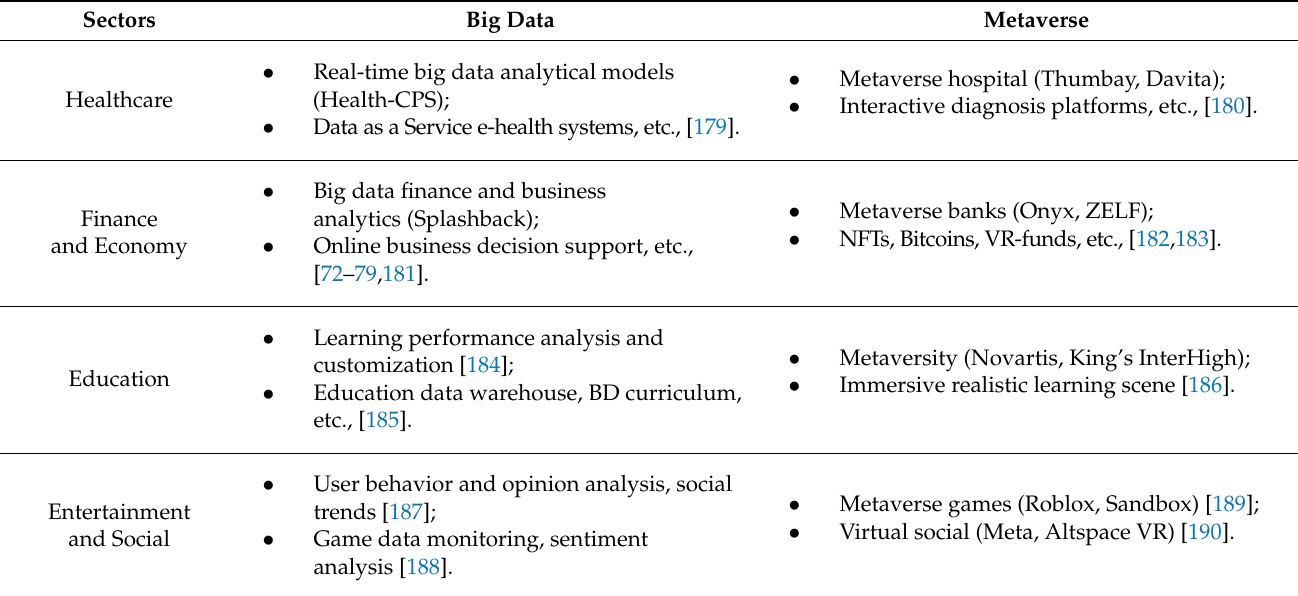
Table 3. A brief review of example applications of big data and the Metaverse in major sectors.